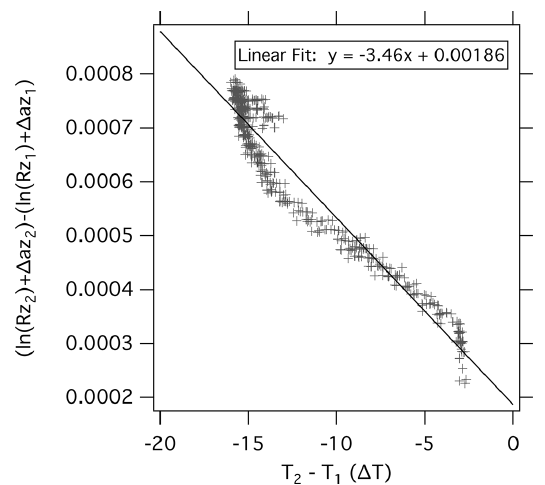
Figure A2. The difference in processed Raman-backscattering sig- nal between reference section 1 and reference section 2 from the WY933 flight versus the difference in temperature between those sections (gray crosses). The linear fit of the data is shown as a black